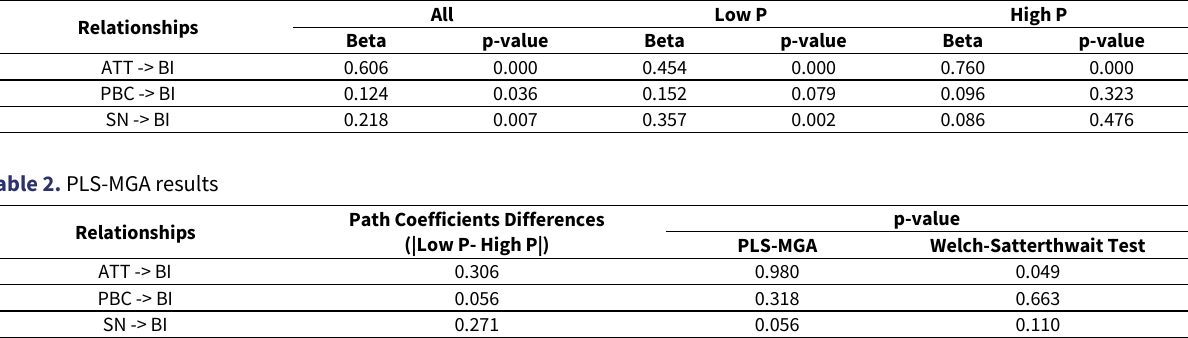
Figure 2. Results from PLS analysis of all collected data Table 1. PLS Structural results